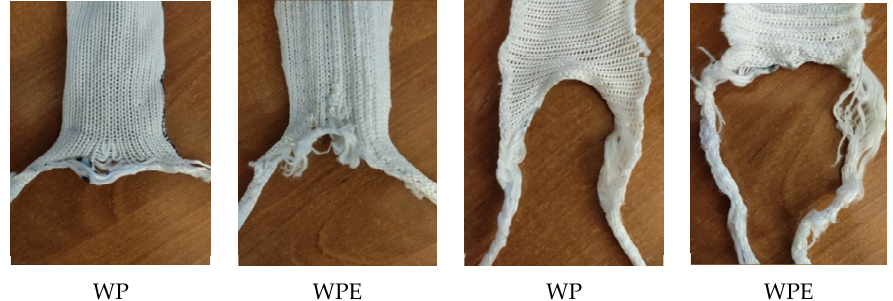
Figure 4. Knitted specimens after the tearing test.